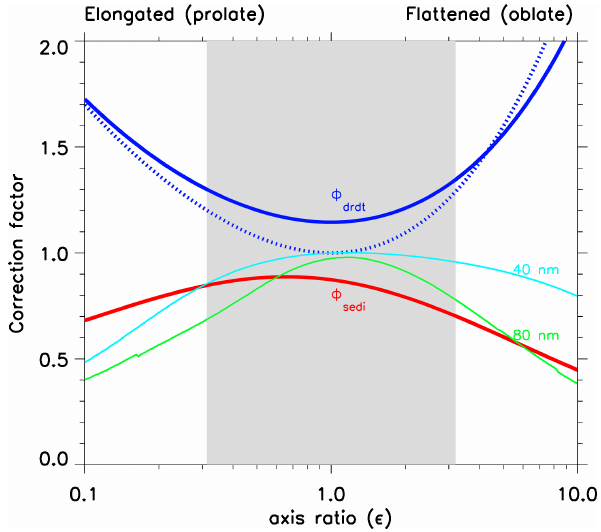
Figure 3. Combinations of color ratios UV / Vis (355 / 532nm) and IR / Vis (1064 / 532nm) for different particle equivalent radii r and axis ratios ε , as calculated from Mie theory for cylindrical parti- cles. Colored solid lines show constant r with variable ε ; the equiv- alent radius in nanometers is shown by the numbers near the ε = 1 position (the line inflection is caused by very small d β at ε = 1). d ε Line oscillations, mainly along the ε < 1 branch, stem from round- ing errors in the Mie scattering tables. The grey scale lines (dot- ted/dashed) show variable r for fixed axis ratios, including cylinders with ε = 1 for the solid black